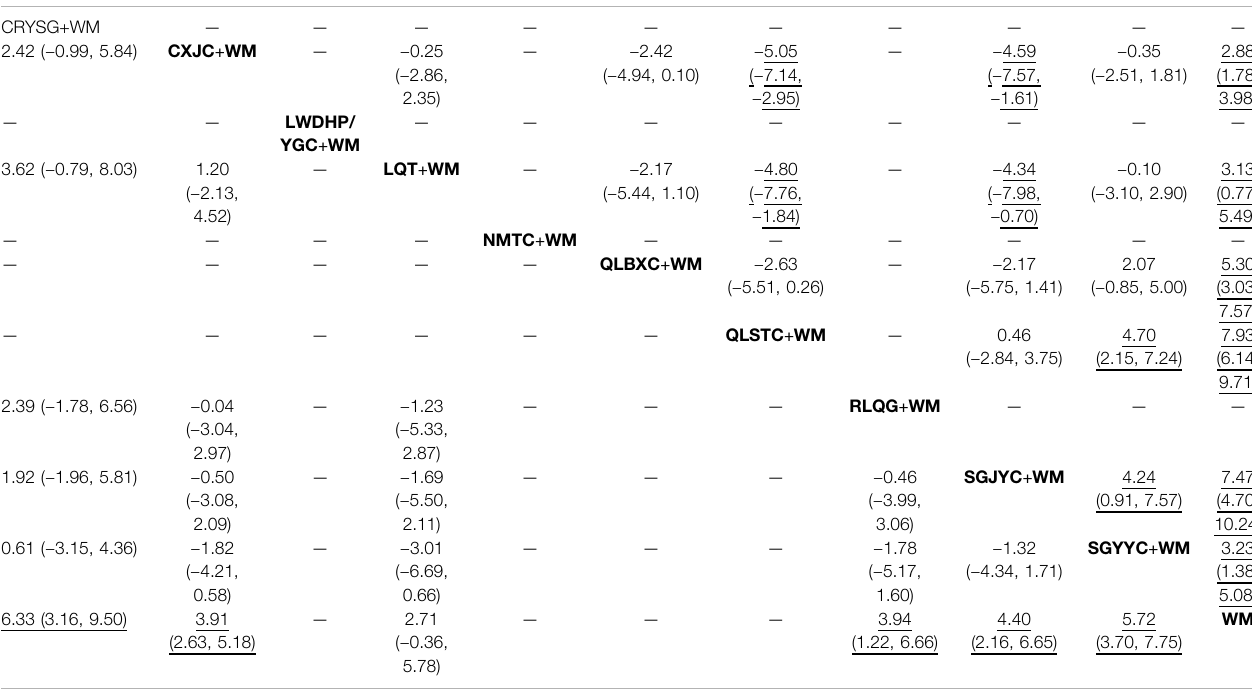
TABLE 2 | Mean difference (95% CIs) of NIH-CPSI (right upper quarter) and IIEF-5 (left lower quarter). CRYSG+WM